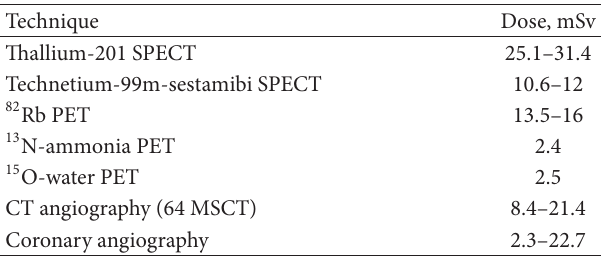
T 2: Comparison of radiation doses for various cardiac diag- nostic